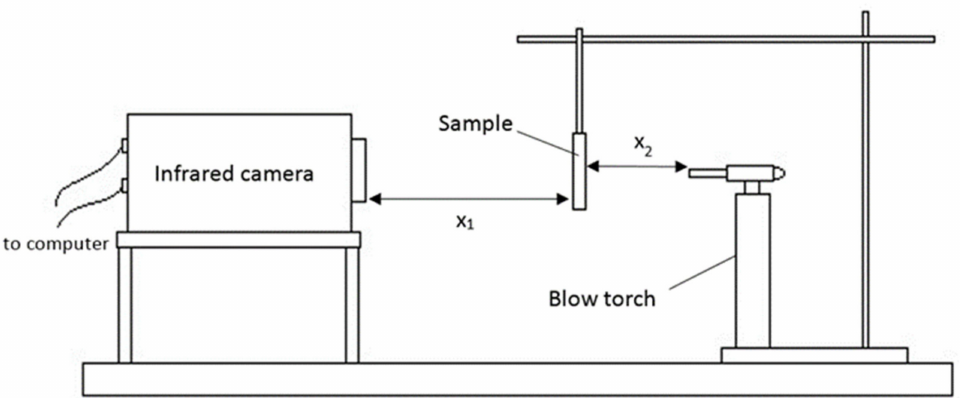
Figure 5. Setup for fire-retardant